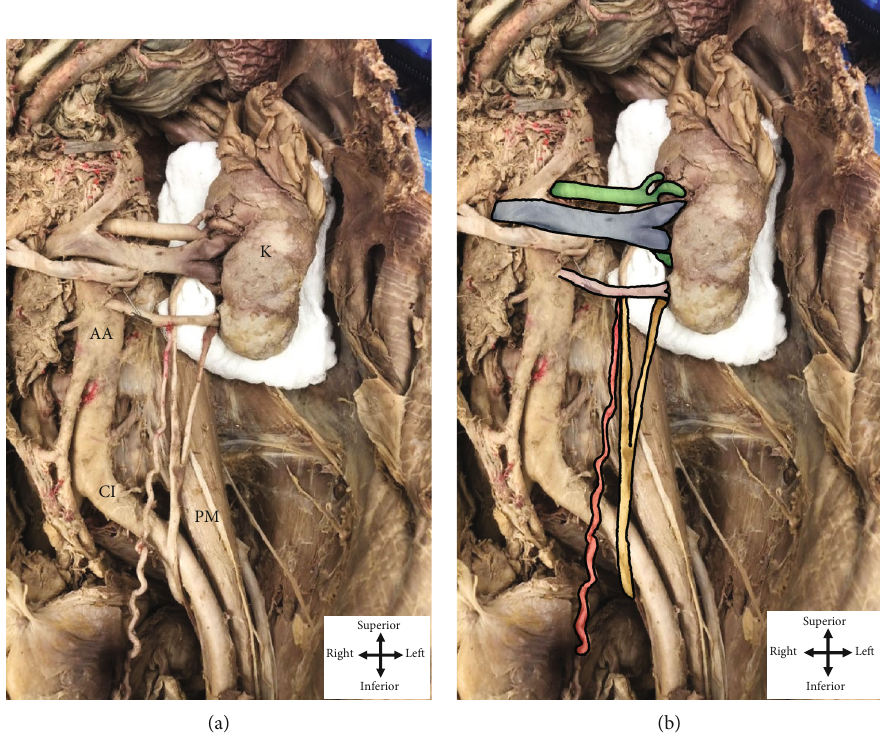
Figure 1: The dissected path of the left bi fi d ureter and aberrant renal artery. (a) depicts the dissected path of the left bi fi d ureter with labeling of relevant landmarks while (b) depicts relevant structures pseudocolored for ease in visualization. The left renal vein (blue in (b)) is observed as the anterior-most structure in the renal hilum, thereby serving as a reference point for relationships in this region. The left renal artery (green in (b)), located posterior to the renal vein, has upper two segments that can be observed entering the superior pole of the kidney (K in (a)). The left aberrant renal artery (pink in (b)) is observed originating from the abdominal aorta (AA in (a)) and branching before reaching the inferior pole of the kidney. As the aberrant artery courses toward the left kidney, it gives o ff the highly coiled left ovarian artery (red in (b)) that descends into the pelvis medial to the left ureter. The superior and inferior contributions to the bi fi d ureter (yellow) emerge from the posterior aspect of the renal hilum and unite to form the left ureter proximal to the bladder and near the anterior surface of the psoas major muscle (PM in (a)). The left ureter crosses over the left common iliac artery (CI in (a)) before entering the pelvis to join the